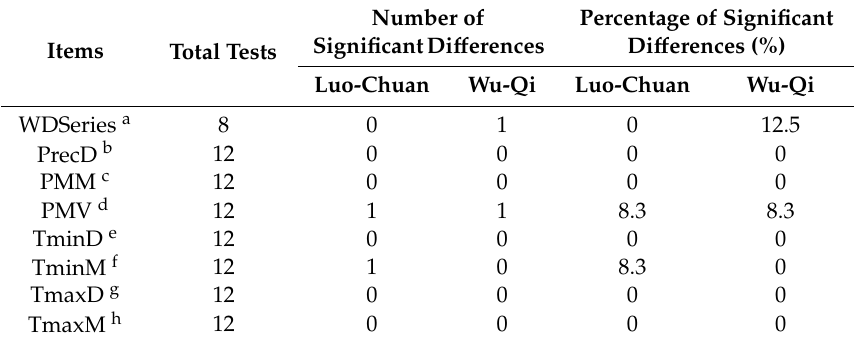
Table 3. Results of the statistical tests comparing the observed data and synthetic data generated by the Long Ashton Research Station Weather Generator (LARS-WG) with the numbers of tests revealing significantly di ff erent results at the 5% significance level. Number of Percentage of Significant SignificantDi ff erences Di ff erences (%) Items Total Tests Luo-Chuan Wu-Qi Luo-Chuan Wu-Qi WDSeries a 8 0 1 0 12.5 PrecD b 12 0 0 0 0 PMM c 12 0 0 0 0 PMV d 12 1 1 8.3 8.3 TminD e 12 0 0 0 0 TminM f 12 1 0 8.3 0 TmaxD g 12 0 0 0 0 TmaxM h 12 0 0 0